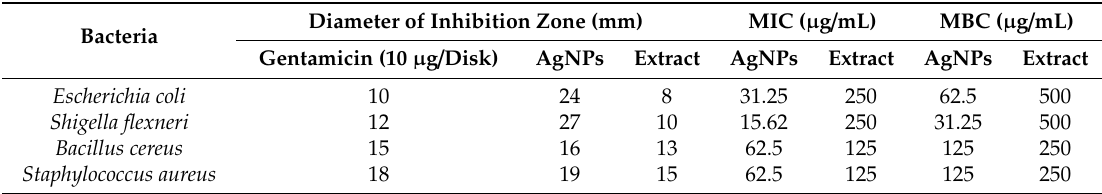
Table 1. The inhibition zone, minimum inhibitory concentration (MIC), and minimum bactericidal concentration (MBC) of the A. tribuloides root extract and the greenly synthesized AgNPs against the tested bacterial